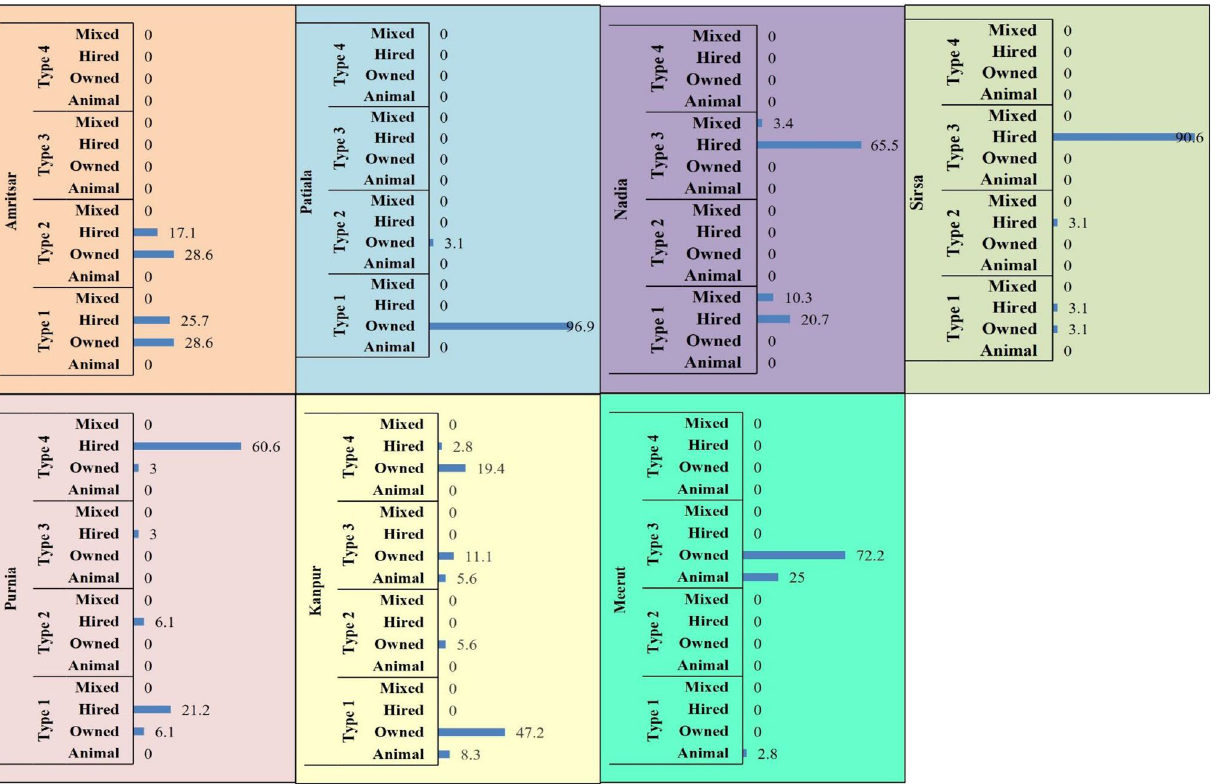
Figure 7. Status of mechanization (%) in different districts w.r.t types. Animal–Animal Power, Mixed − (Owned + Hired + Animal